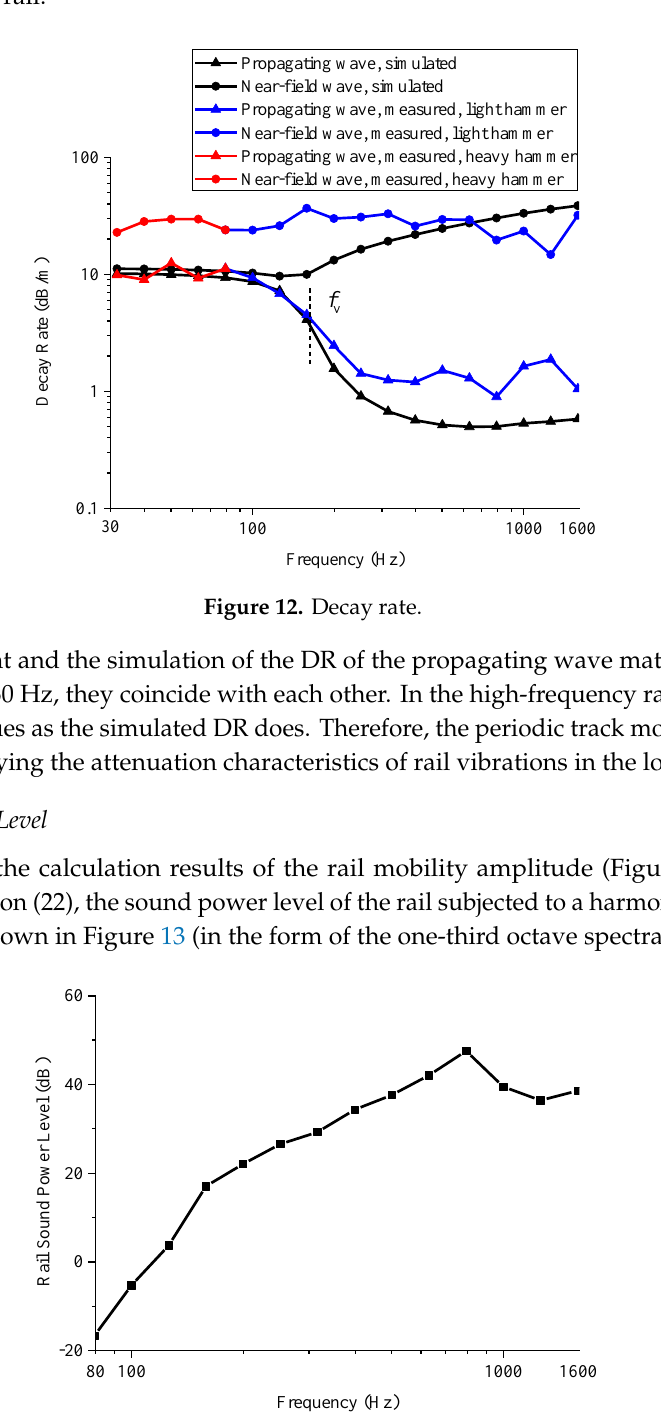
Figure 13. Sound power level of the rail subjected to a harmonic point excitation.